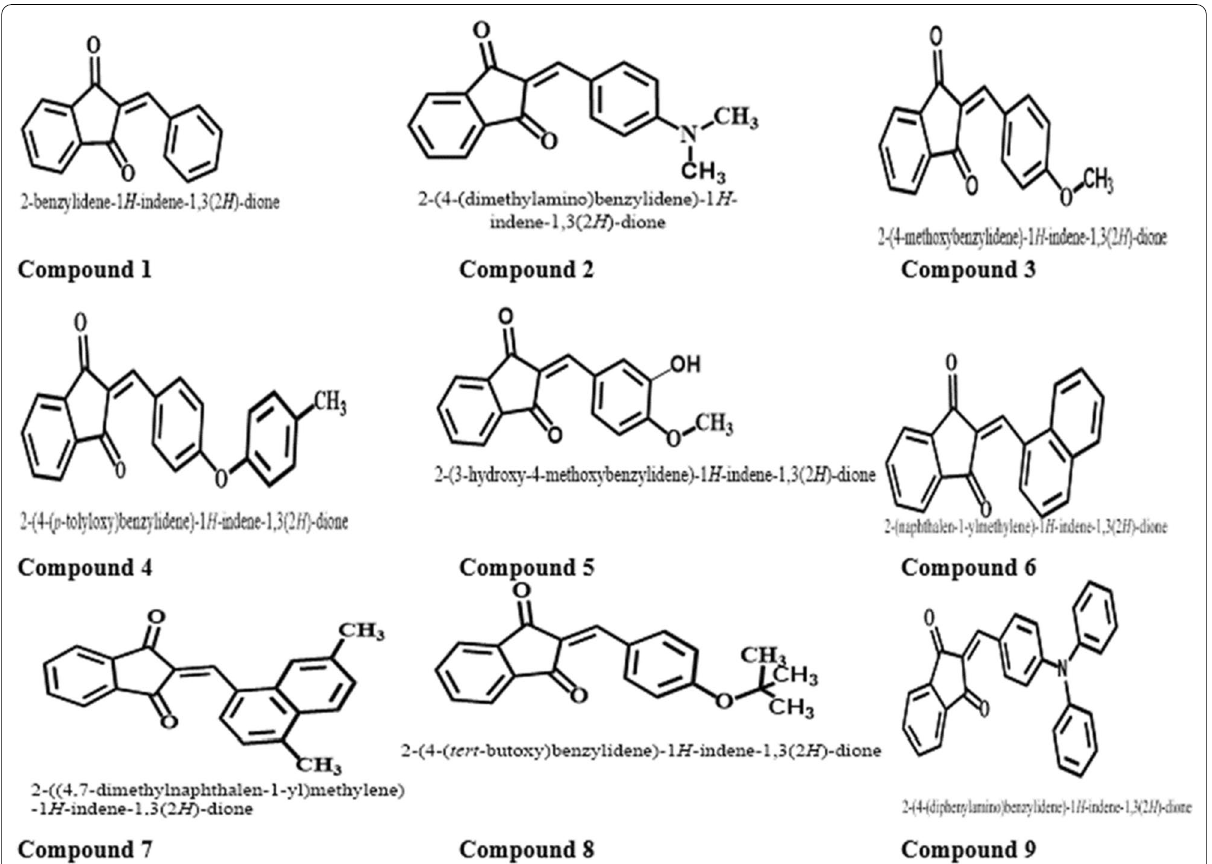
Fig. 1 Structures of the 2-arylidene-indan-1,3-dione derivatives (Compounds 1 to